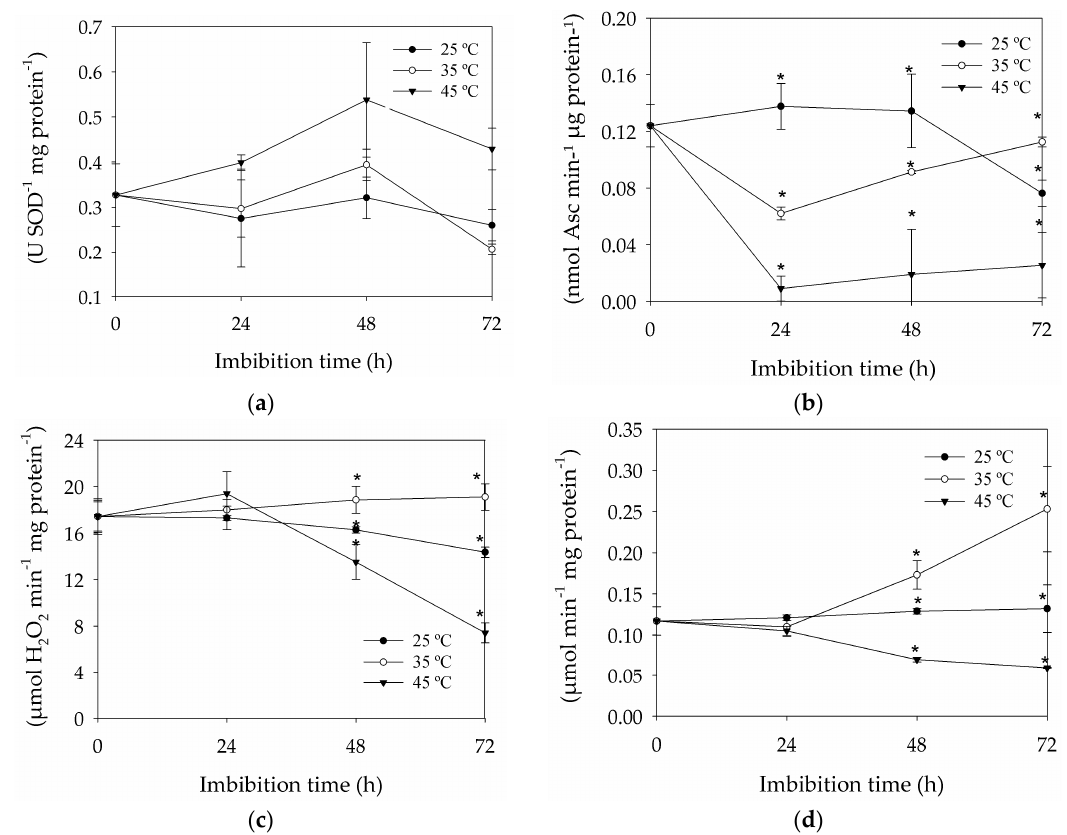
Figure 5. Specific activities of enzymes superoxide dismutase (SOD) ( a ), ascorbate peroxidase (APX) ( b ), catalase (CAT) ( c ), and peroxidase (POX) ( d ) in the embryonic axis of Melanoxylon brauna seeds during the germination period, after soaking at 25, 35, and 45 °C. * Mean statistical difference between means. Vertical bars = ±SE, n = 5.